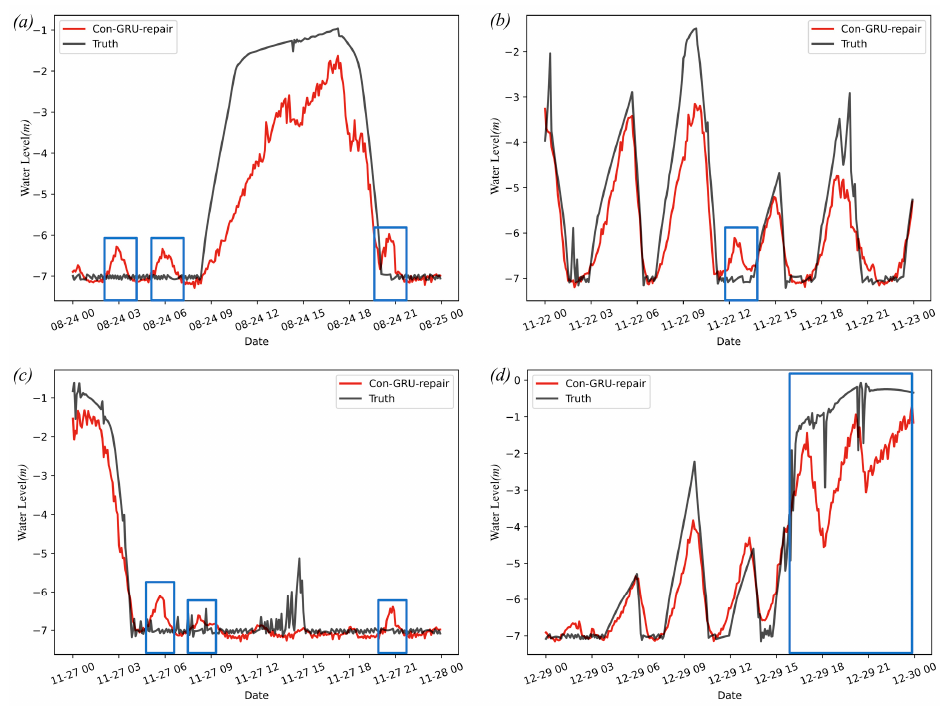
Figure 9. Comparison of the Con-GRU model in iterative repair on test dataset: ( a ) results of data repair on 24 August 2020; ( b ) results of data repair on 22 November 2020; ( c ) results of data repair on 27 November 2020; ( d ) results of data repair on 29 December